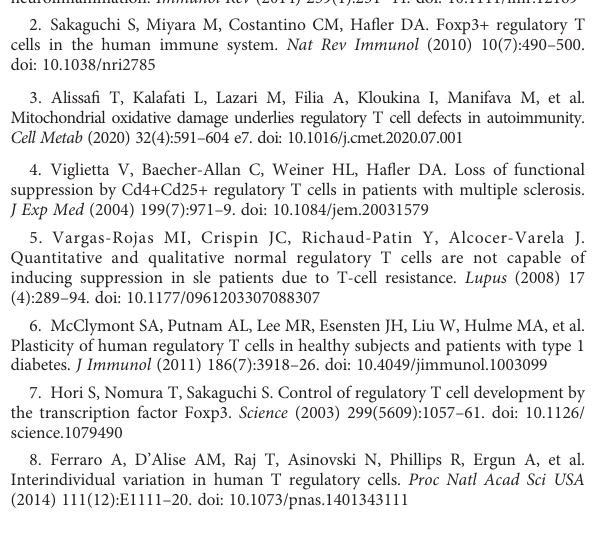
one-way ANOVA with Sidak ’ s multiple comparisons test or (C) Kruskal- Wallis test with Dunn ’ s multiple comparisons test. SUPPLEMENTARY FIGURE 4 Re-analysis of expression of CD131-associated cytokine receptors on CD4 + Tconv and Treg populations. mRNA expression was studied in published Treg signature data (A) GSE90600 (11) or (B, C) GSE76598 (10). (A) RNAseq was performed in cells sorted from blood of 3 healthy donors based on CD4, CD25 and CD45RA expression. CD4 + T cells were isolated as: CD45RA + CD25 - naive T cells (nTconv), CD45RA - CD25 - memory T cells (mTconv), CD45RA - CD25 int , CD45RA + CD25 + naive Tregs (nTreg) and CD45RA - CD25 high effector Tregs (eTreg). (B, C) Cells were sorted from blood of 7 healthy donors as: CD4 + CD45RA + CD25 - naive T cells (nTconv), CD4 + CD45RA - CD25 - memory T cells (mTconv), CD4 + CD45RA + CD25 + naive Tregs (nTreg) and CD4 + CD45RA - CD25 + memory Tregs (mTreg). RNA expression was studied in (B) ex vivo cell subsets or (C) after 40 hours of stimulation with anti-CD3 and anti-CD28 antibodies. Signi fi cance was calculated by one-way ANOVA with Sidak ’ s multiple comparisons test for normally-distributed data or by a Kruskal- Wallis test with Dunn ’ s multiple comparisons test for data non- normally